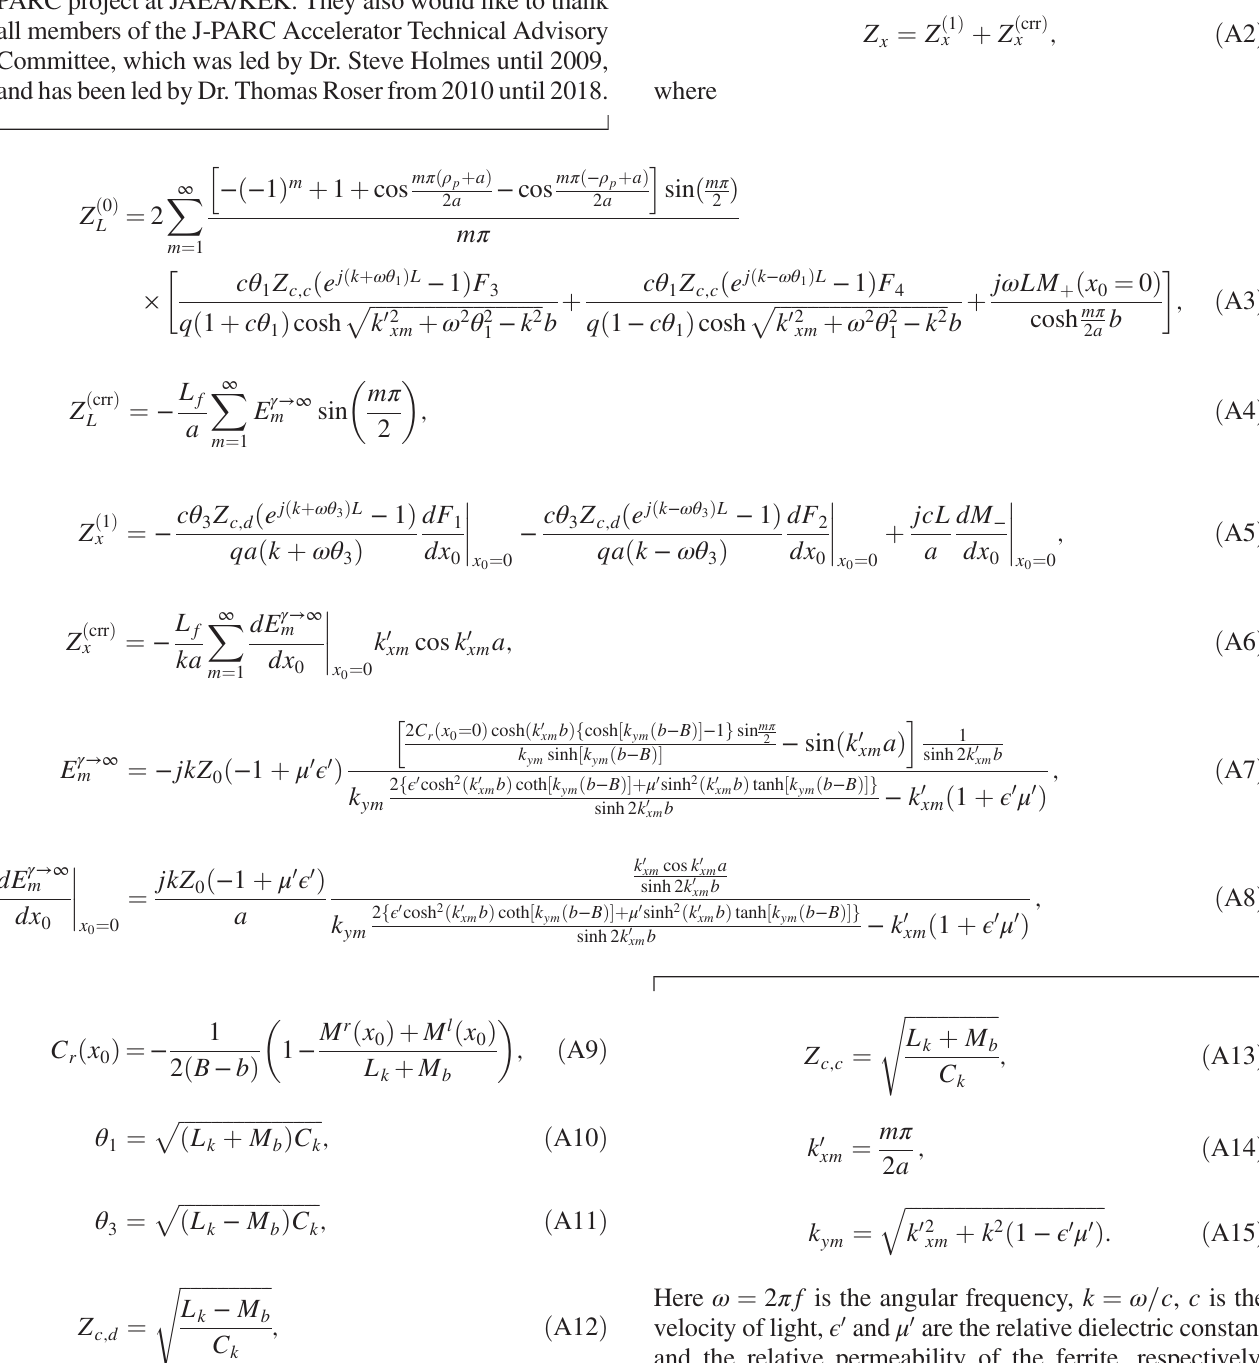
p k 0 2 ω 2 θ 2 − k 2 xm þ 1